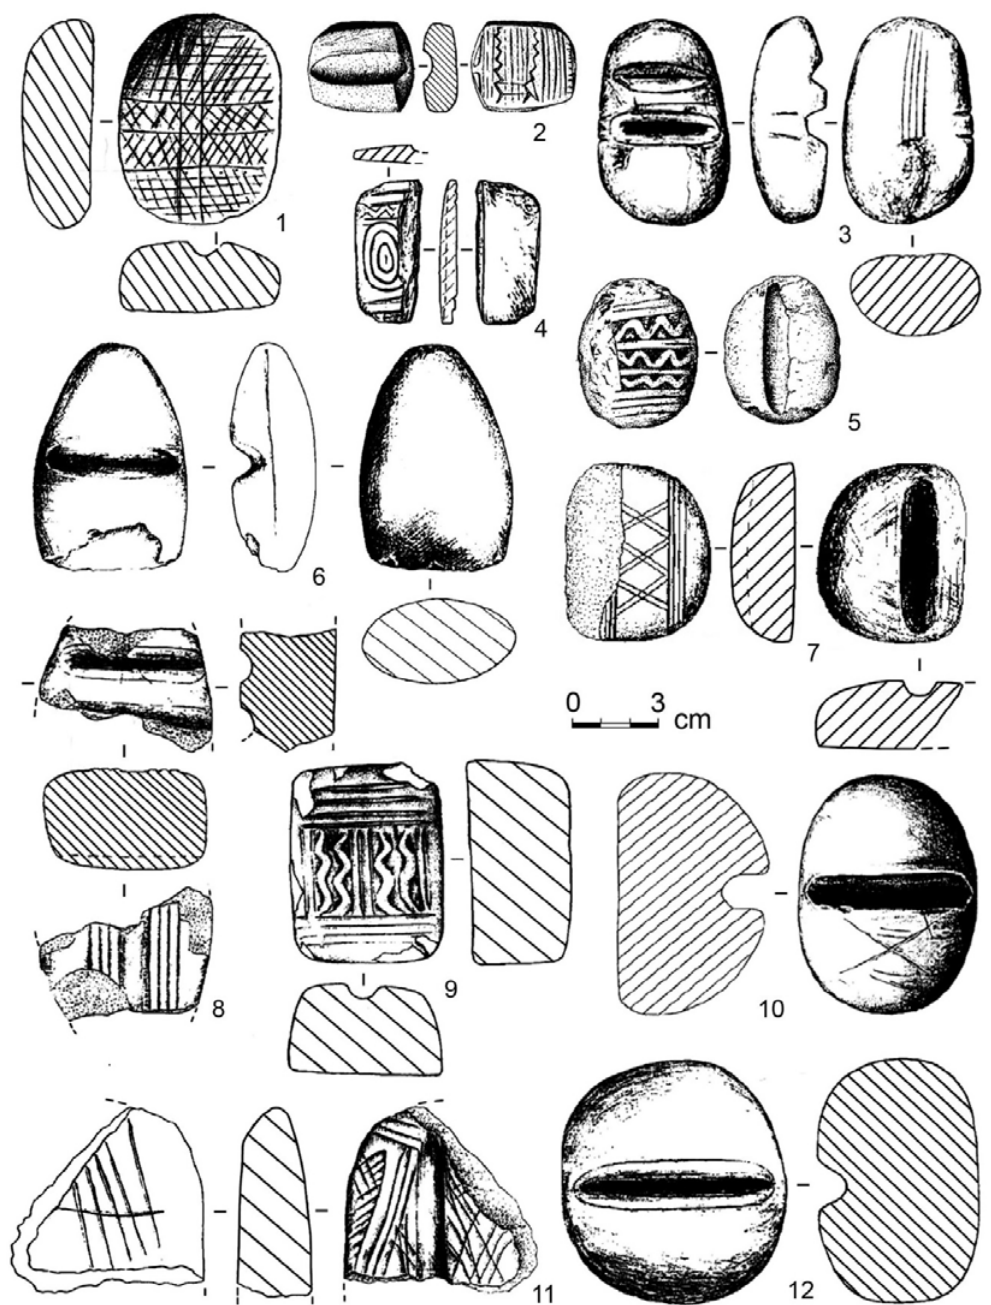
Figure 5. Grooved stones of “The Golden Triangle” (Upper Mesopotamia). 1, 3, 4, 6-12: Tell Qaramel (Mazurowski & Kanjou 2012: fig. 68, 1; 69, 4; 71, 2; 73, 5; 74, 4; 75, 6; 77, 5; 78, 3, 4, 6); 2: